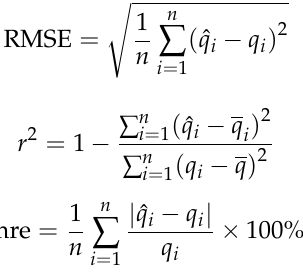
Figure 6. Comparison of prediction results for the three models.